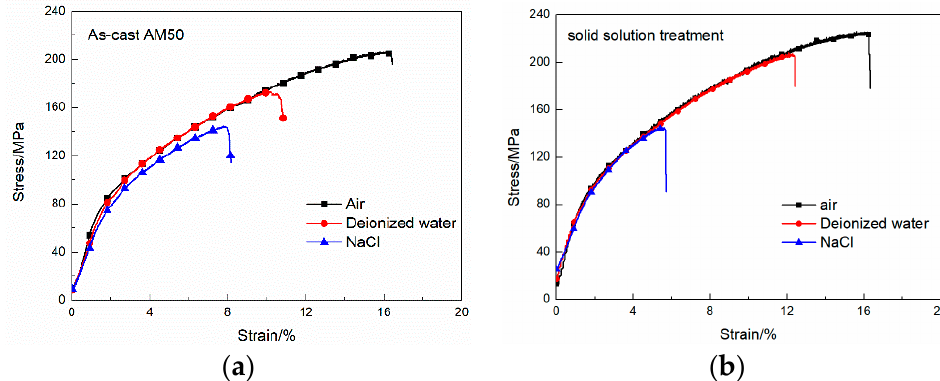
Figure 4. SSRT curves of the ( a ) as-cast and ( b ) solid-solution-treated AM50 magnesium alloy samples in air, deionized water, and 3.5% NaCl aqueous solution.